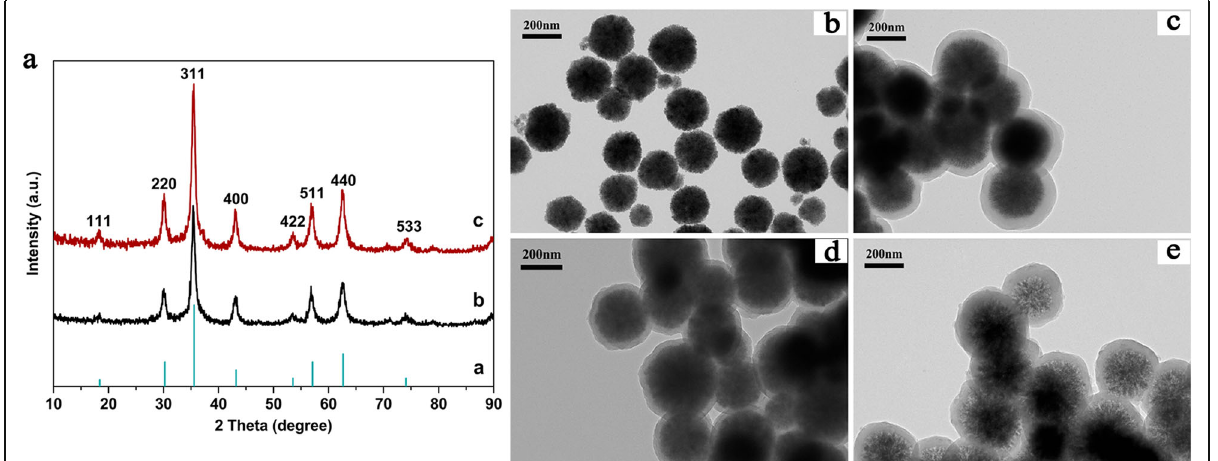
Fig. 1 a X-ray diffraction (XRD) patterns of (a) standard Fe 3 O 4 , (b) synthesized Fe 3 O 4 , and (c) Fe 3 O 4 @PDA; TEM images of b Fe 3 O 4 , c Fe 3 O 4 @PDA, d